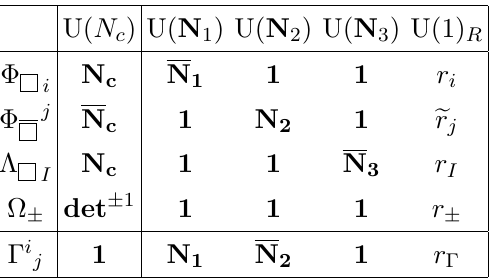
Table 1 . Charges of the matter (cid:12)elds in 2 d = (0 ; 2) SQCD. The det and det (cid:0) 1 representation N assigns charge +1 and 1, respectively, to each U(1) a U( N c ), a = 1 ; ; N c , in the Cartan (cid:0) (cid:26) (cid:1) (cid:1) (cid:1) subgroup of U( N c ). The last line is the fermi gauge-singlet in (cid:0)-SQCD. brie(cid:13)y discuss a related setup with D-branes at Calabi-Yau singularities. Our conventions are summarized in